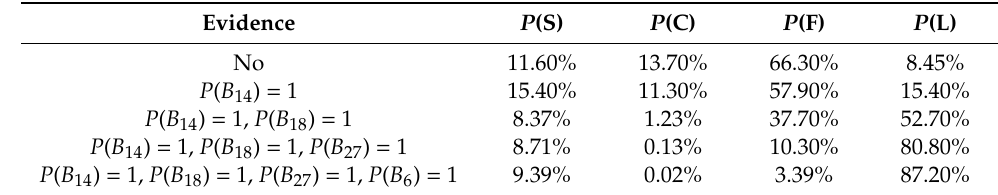
Table 4. Prediction without and with evidence for the second